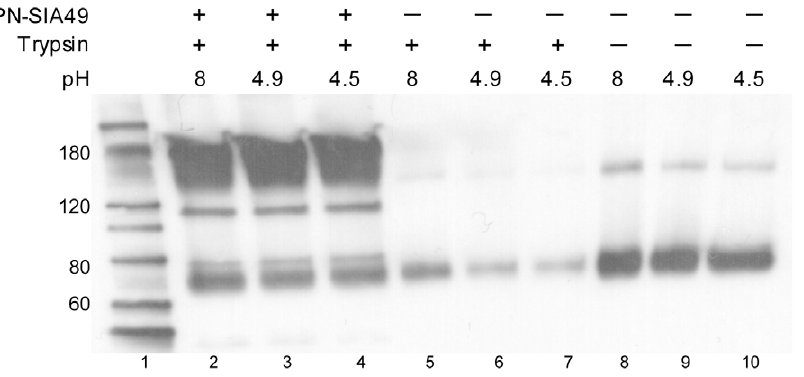
Figure 2. PN-SIA49 protects H1-HA from the low pH induced protease sensitivity. Western Blotting results of the protease susceptibility assay for H1-HA. Exposure to low pH converts HA to the protease-susceptible, post-fusion state (lane 6 and 7). Pre-treatment with PN-SIA49 partially blocks the pH-induced conformational change retaining HA in the protease-resistant, pre-fusion state (lane 3 and 4). In lanes 2–4 is also visible the signal given by PN-SIA49 (180 KDa). The other bands (about 110 KDa and 190 KDa) are due to HA aggregates bound by PN-SIA49 or by the primary anti-influenza Ab used in the western blotting assay.